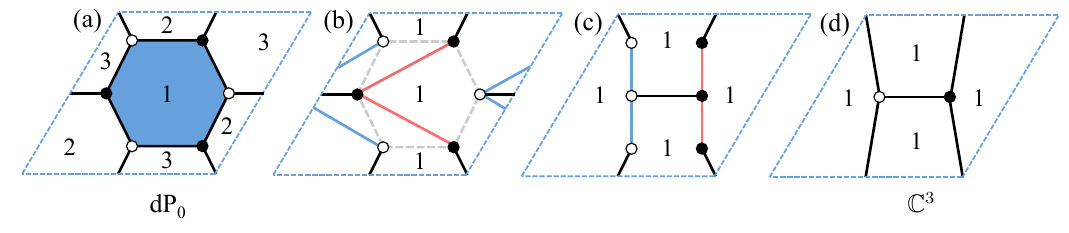
Figure 16. Instanton backreaction from dP 0 to C 3 .